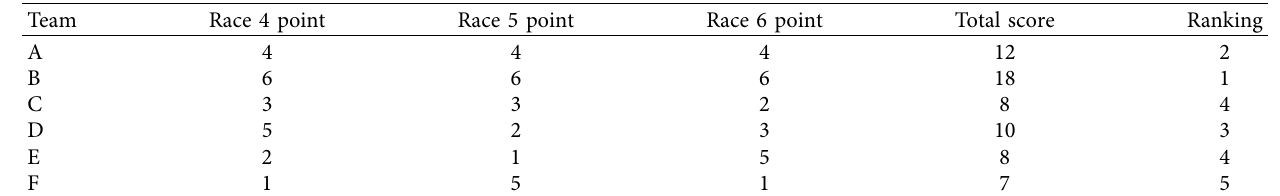
Table 2: Score ranking from next 3